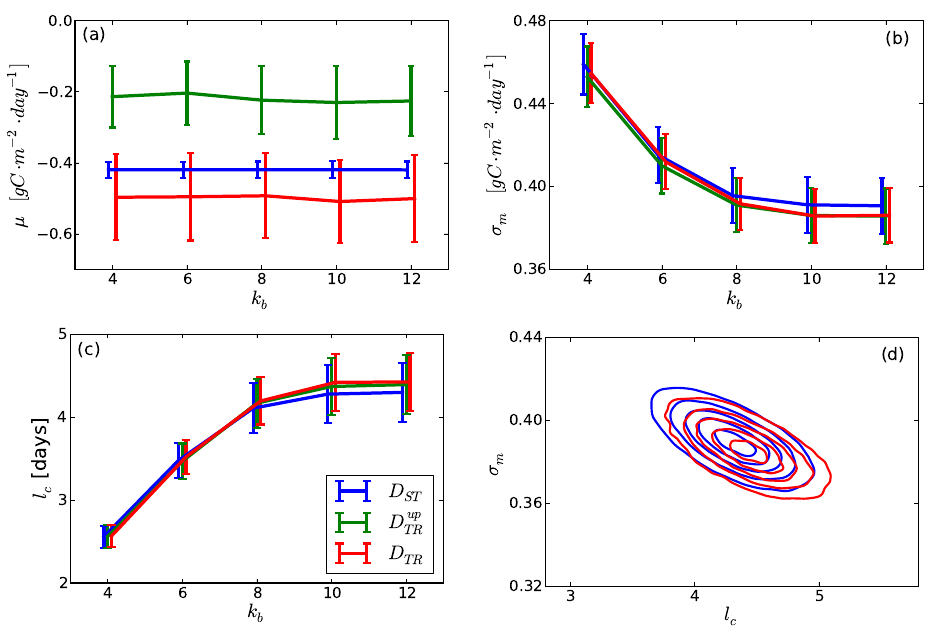
Figure 12. Convergence of model error components with increasing bandwidth of the covariance matrix: (a) µ , (b) σ m , and (c) l c . The joint 2-D marginal density of (σ m ,l c ) for k b = 12 is shown in (d) . In addition to D ST and D TR setups, we also considered “D up equivalent to D TR , but with uniform priors assumed for the vegetation and soil carbon